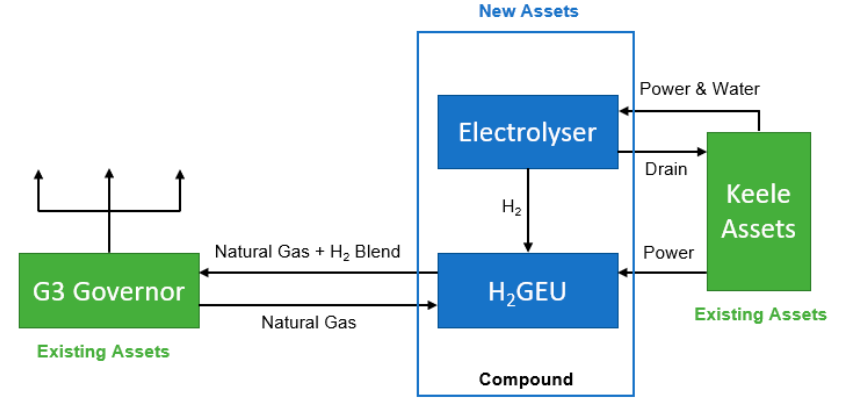
Figure 11. HyDeploy process design flow chart (adapted from [76]).